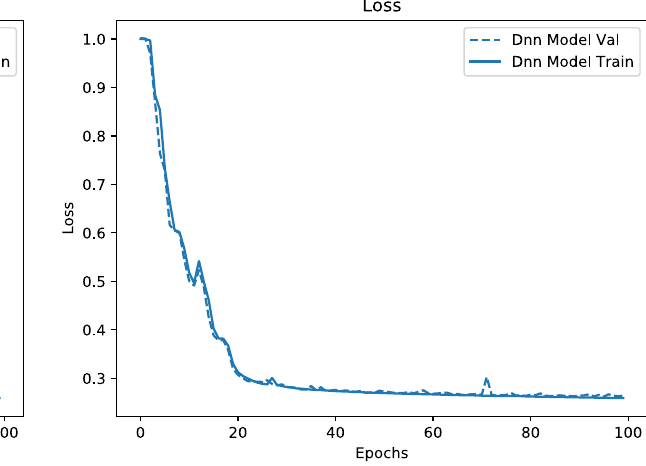
Fig. 17 Shape of the loss function related to a specific neural network topology used for regression in the semi-leptonic and fully-leptonic channel.Thedecreasingoflossvaluesaminimumvaluecanbeappreci-